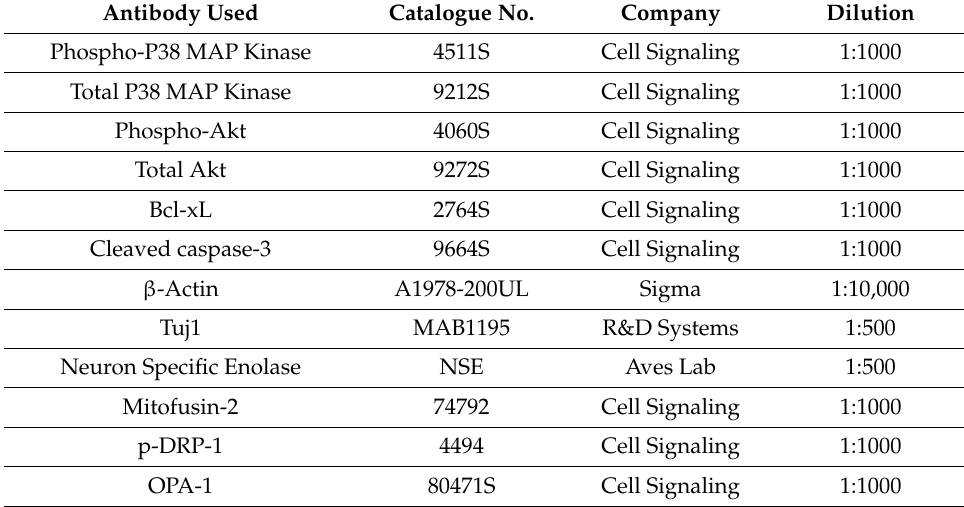
Table A1. List of antibodies used in the